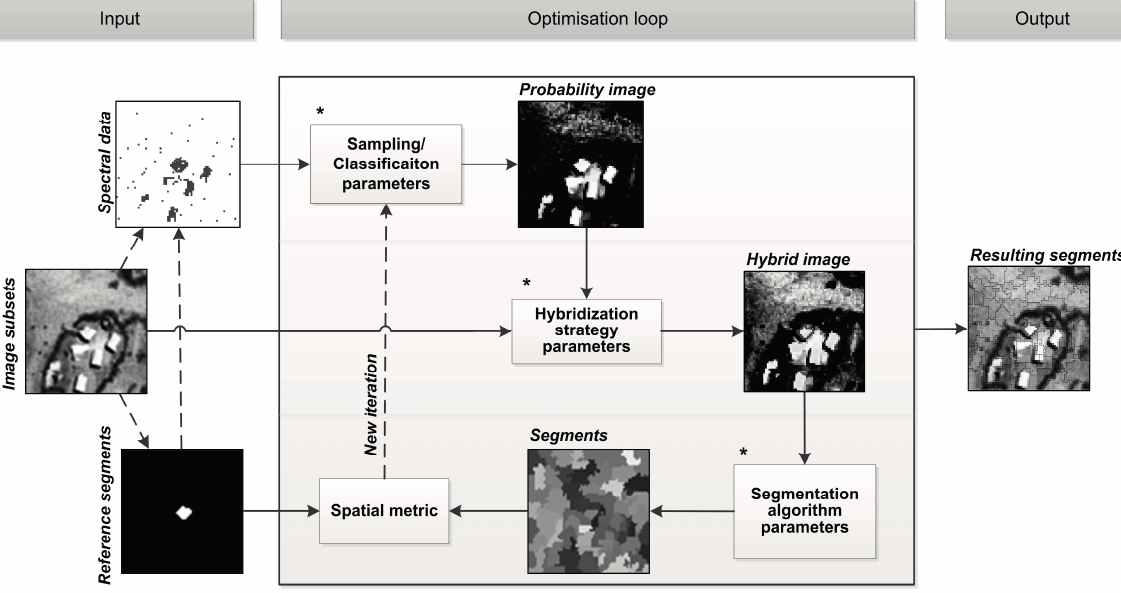
Figure 3. Architecture of the variant of sample supervised segment generation incorporating classifier directed data hybridization